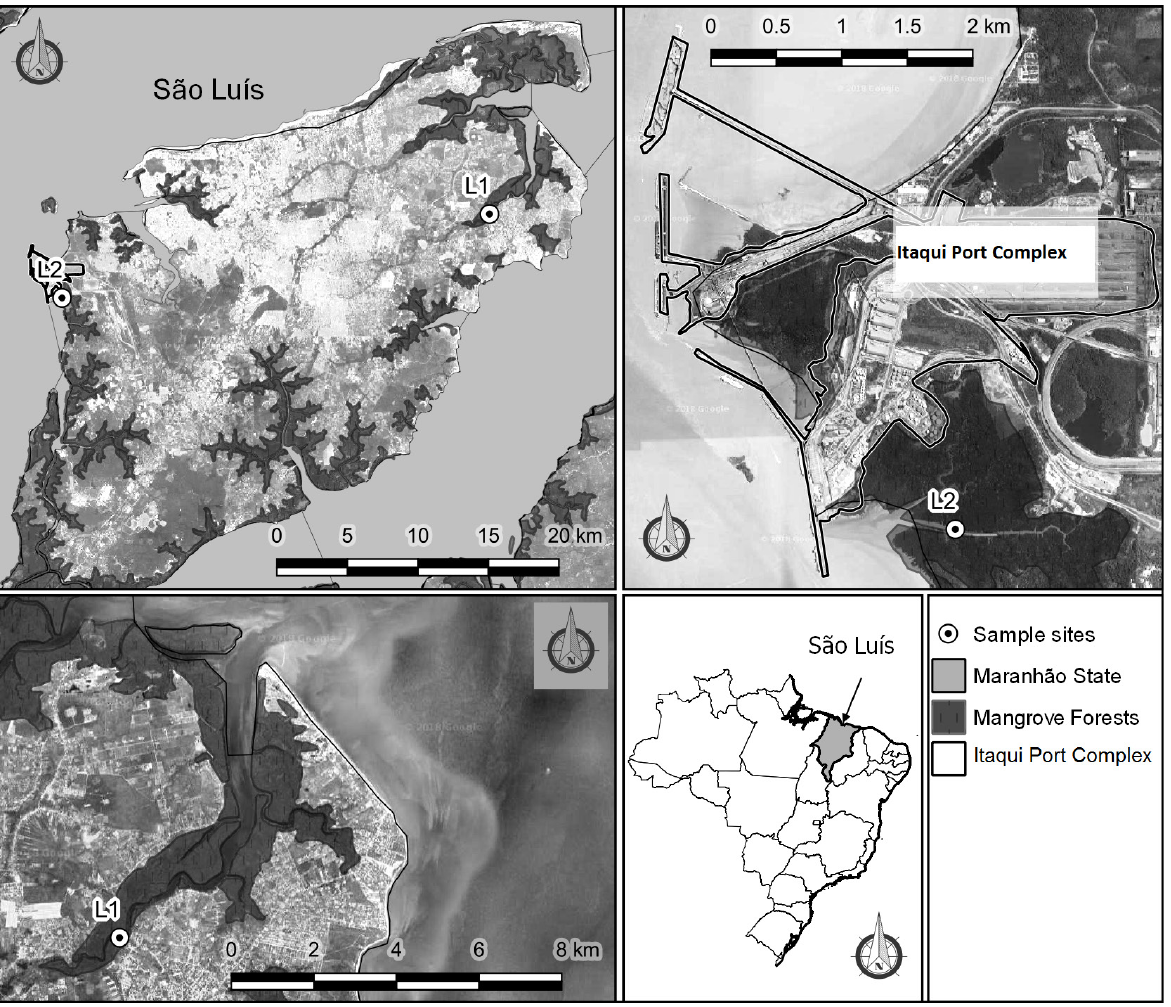
Figure 1. Sampling sites for Sciades herzbergii in Maranhão state, northeastern Brazil. L1 = reference site ( Pau Deitado ) distant from ports and urban centers/industries; L2 = Irinema Pequeno Stream at the vicinity of the Itaqui Port Complex (Map by Diego